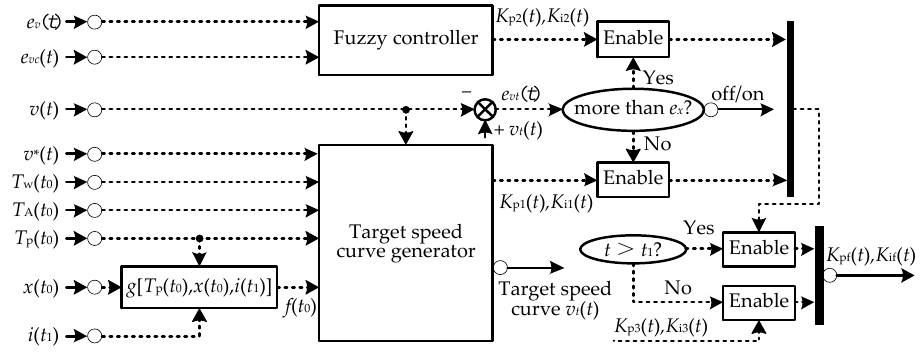
Figure 2. Structure of fitted data generator.